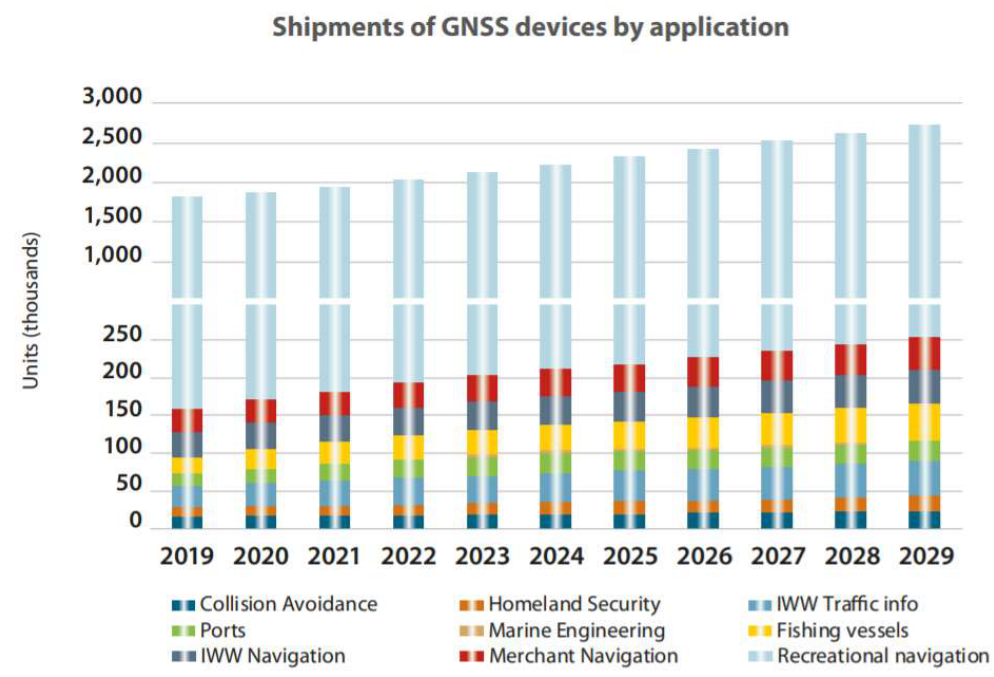
Figure 1. Global Navigation Satellite System (GNSS) units shipments by application (reproduced from [3], with permission from the European Global Navigation Satellite Systems Agency (GSA), 2019.